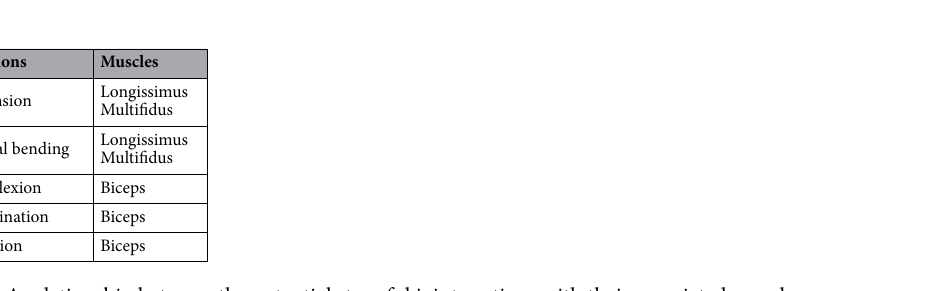
Table 3. A relationship between the potential stressful joint motions with their associated